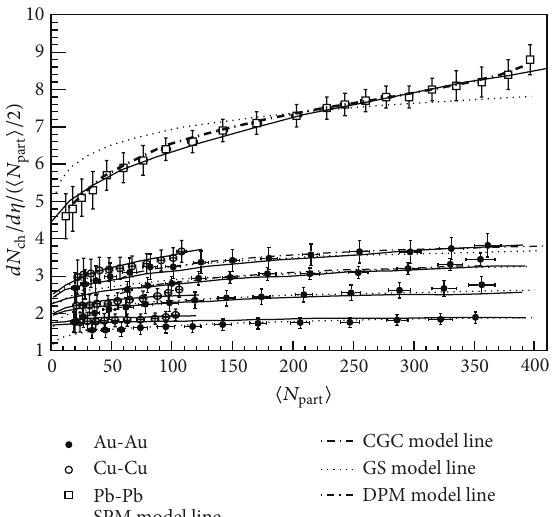
Figure 12: Centrality dependence of scaled mid-pseudo-rapidity density of charged hadrons with different colliding nuclei at RHIC and LHC energies [118, 137]. Solid lines are the SPM results [90], dash-dotted lines are CGG model results, and dotted lines are GS results